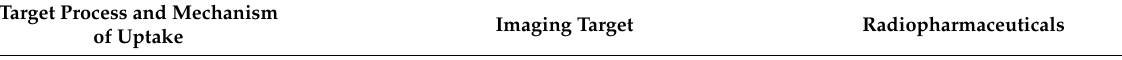
Table 1. Radiopharmaceuticals used for imaging atherosclerotic plaques. Target Process and Mechanism of